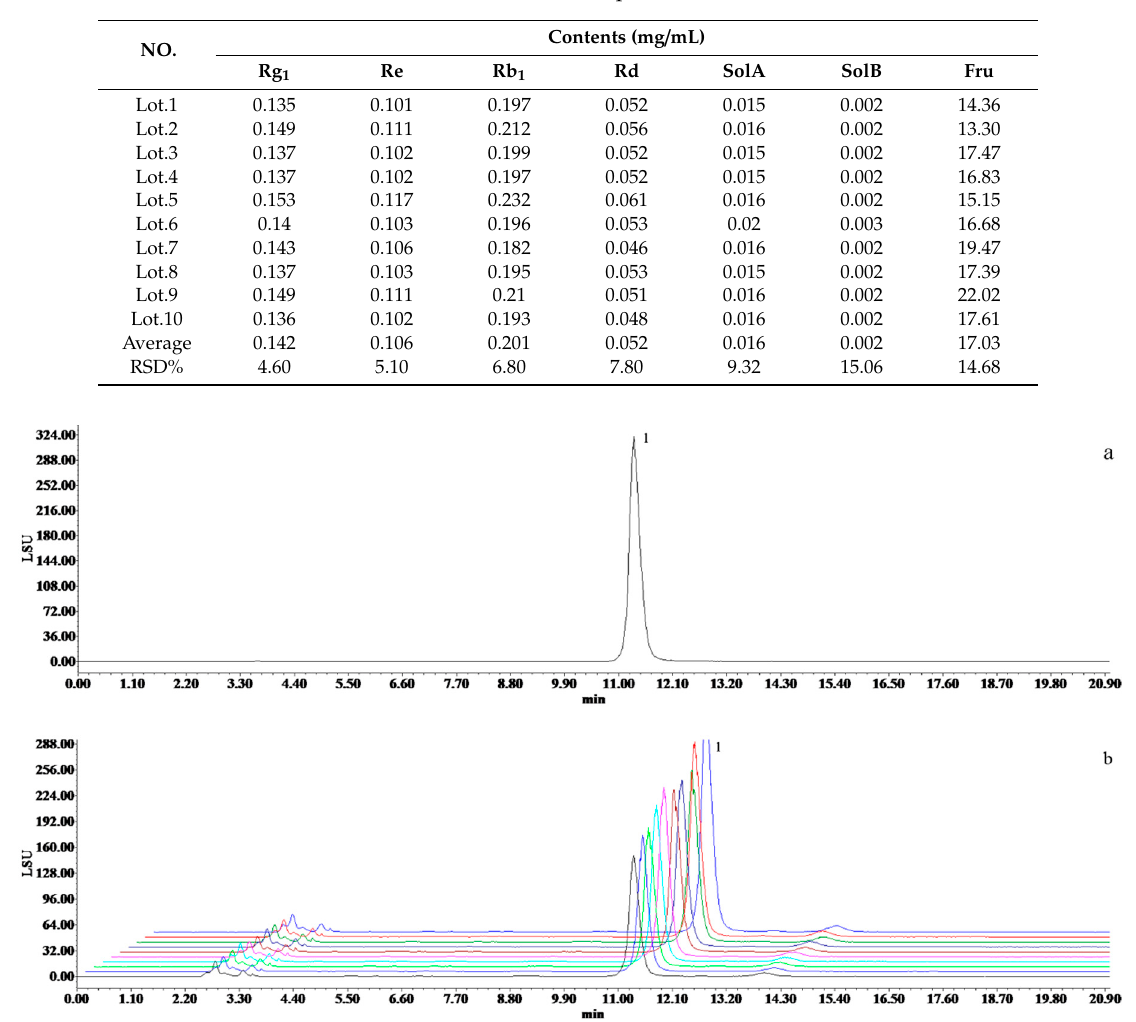
Figure 8. HPLC-ELSD chromatograms of ( a ) the reference solution of fructose, ( b ) the fingerprint of 10 batches of SMI (1: